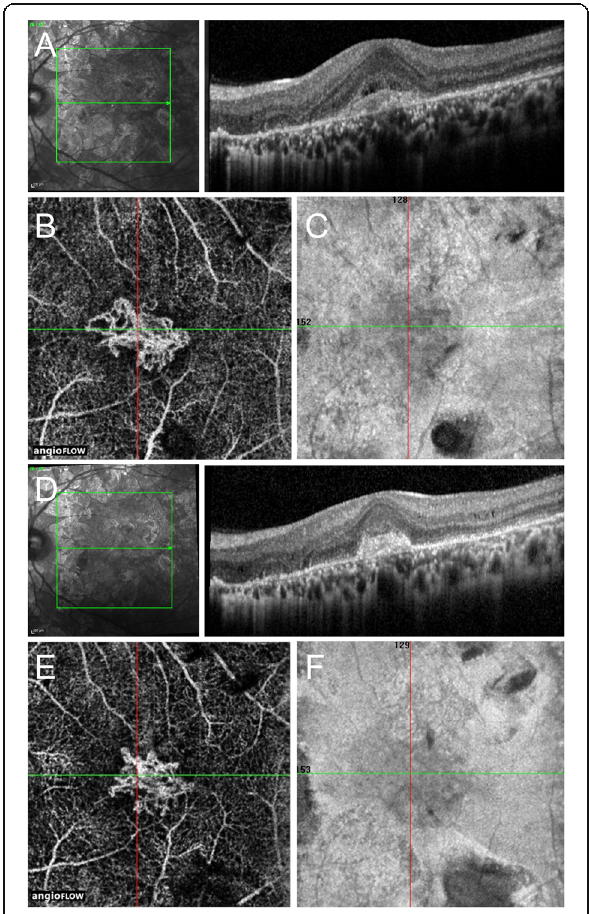
Fig. 3 Multimodal imaging of inflammatory choroidal neovascularization (CNV) (medusa head appearance) in a case of multifocal choroiditis. a The optical coherence tomography line scan passing through the fovea shows a hyper-reflective lesion in the outer retina with the presence of mild subretinal fluid suggestive of a type 2 CNV. b , c Optical coherence tomography angiography (OCTA) en face 3×3 mm scan (along with structural en face OCT scan) confirms the presence of a CNV lesion with a medusa head appearance. Similar to Fig. 2, manual segmentation of the scan has been performed to obtain a slab of 60 μ m thickness including the outer retina and choriocapillaris to allow better delineation of the CNV. d The OCT line scan at 8-month follow-up after one injection of intravitreal ranibizumab shows the persistence of outer retinal hyper-reflectivity but resolution of subretinal fluid. e , f At this visit, the OCTA en face scan (with corresponding structural en face scan) shows a decrease in the size of the CNV lesion along with a decrease in vessel caliber and